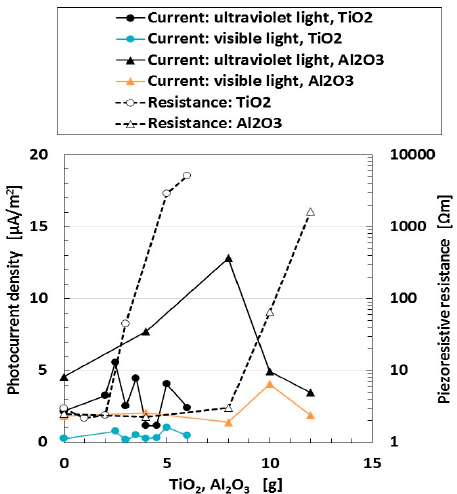
Figure 5. Change in photocurrent density and piezoresistive resistance under visible and ultraviolet light versus the amount of Al 2 O 3 and TiO 2 for wet-type MCF rubber solar cell electrolytically polymerized under a magnetic field with ruthenium complex dye and KI + I 2 electrolyte. The right ordinate in the figure presents the specific resistance at non-irradiation.